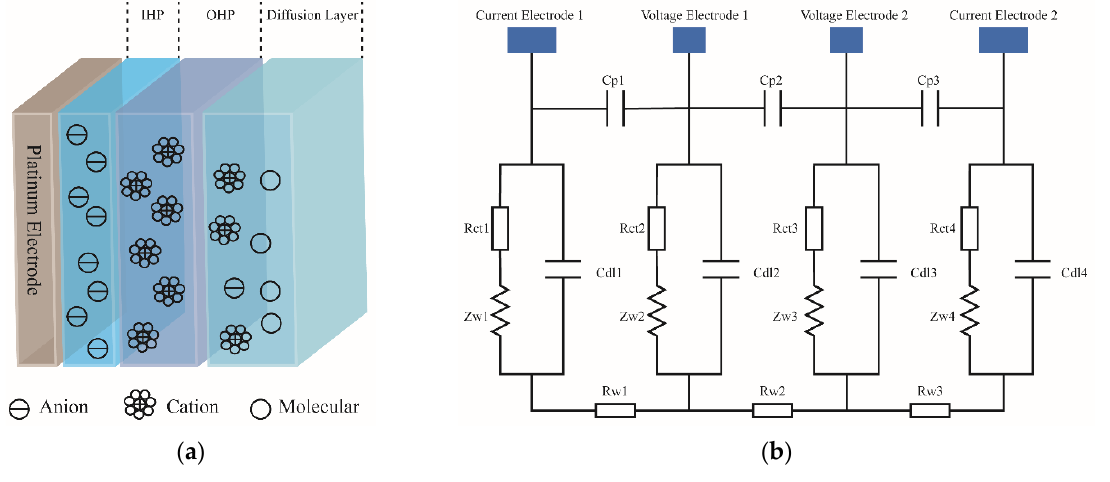
Figure 1. ( a ) A diagram demonstrating the structure of the electrode–electrolyte interface; ( b ) the equivalent circuit diagram of a four-electrode conductivity sensor with AC excitation applied to current electrode and voltage drop measured by voltage electrode.